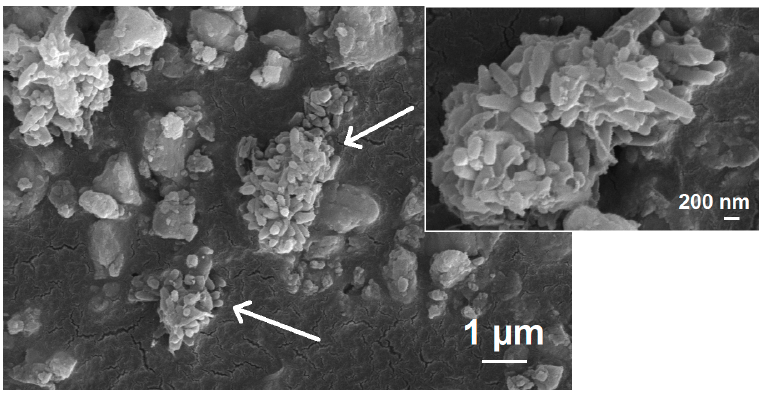
Figure 9. SEM image of the wear debris of the composite GNS/AA1050. A detail of agglomerated nanoparticles is shown on the right. nanoparticles is shown on the right.